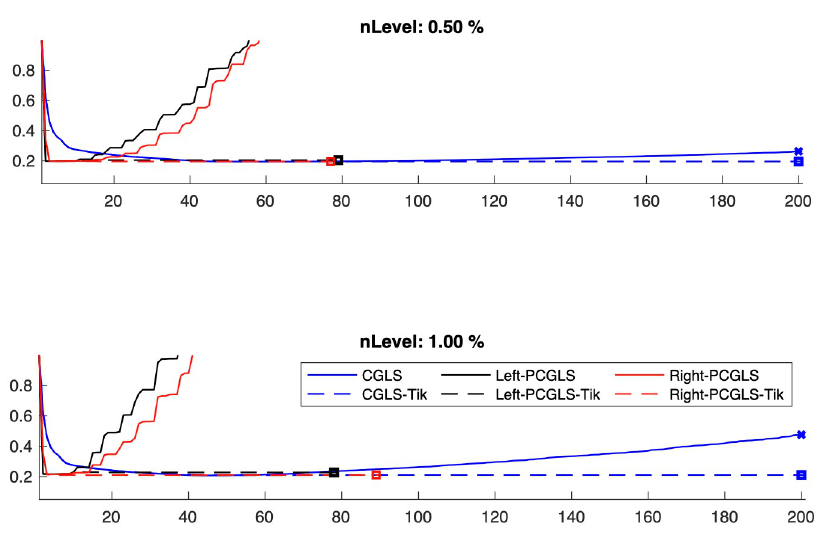
Fig 7. Results for preconditioned iterative methods. Relative reconstruction errors for preconditioned versus unpreconditioned iterative methods for Tikhonov regularization.